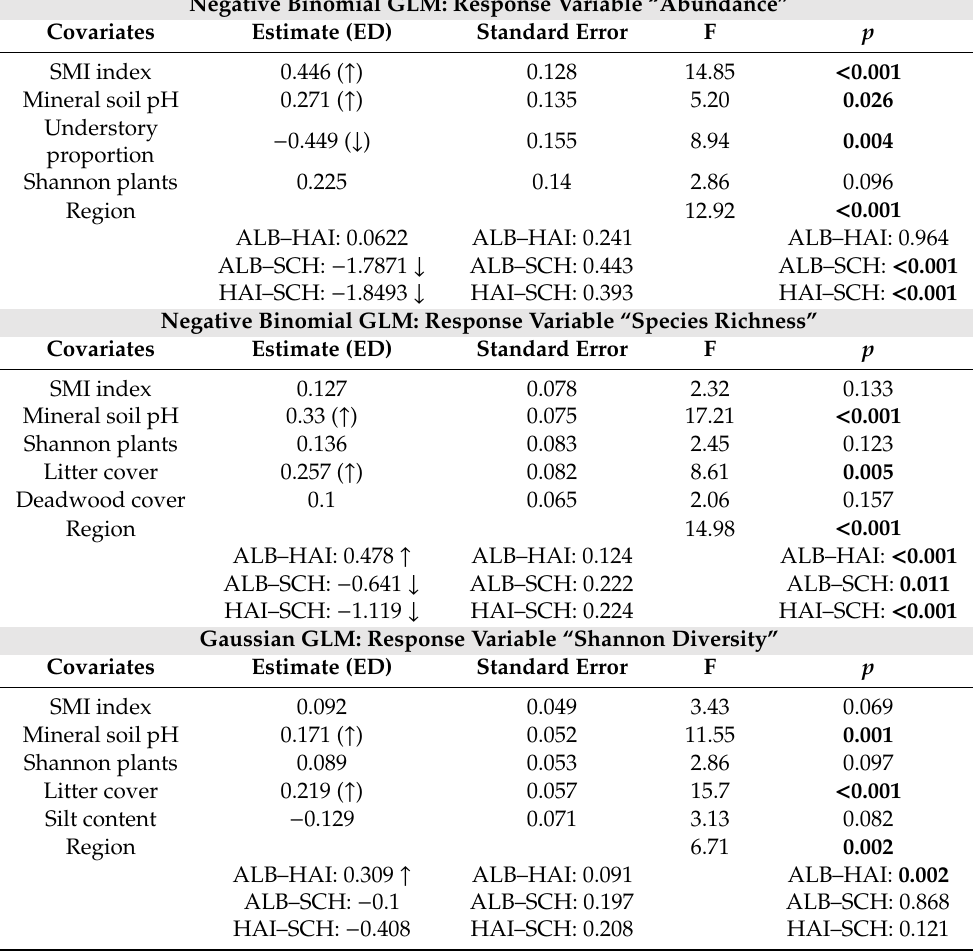
Table 1. Results of the best fitted generalized linear model (GLM) analyses showing the e ff ects of forest management (SMI index), environmental parameters, and region on rove beetle abundance and diversity (species richness, Shannon diversity) on piglet cadavers at 65 forest study sites. ED (significant e ff ect direction) ↑ / ↓ = positive / negative, F = F value, p = significance level. Significant ( p < 0.05) p -values are given in bold. Intercepts are not shown. Post hoc tests for estimated marginal means are shown for the categorial variable